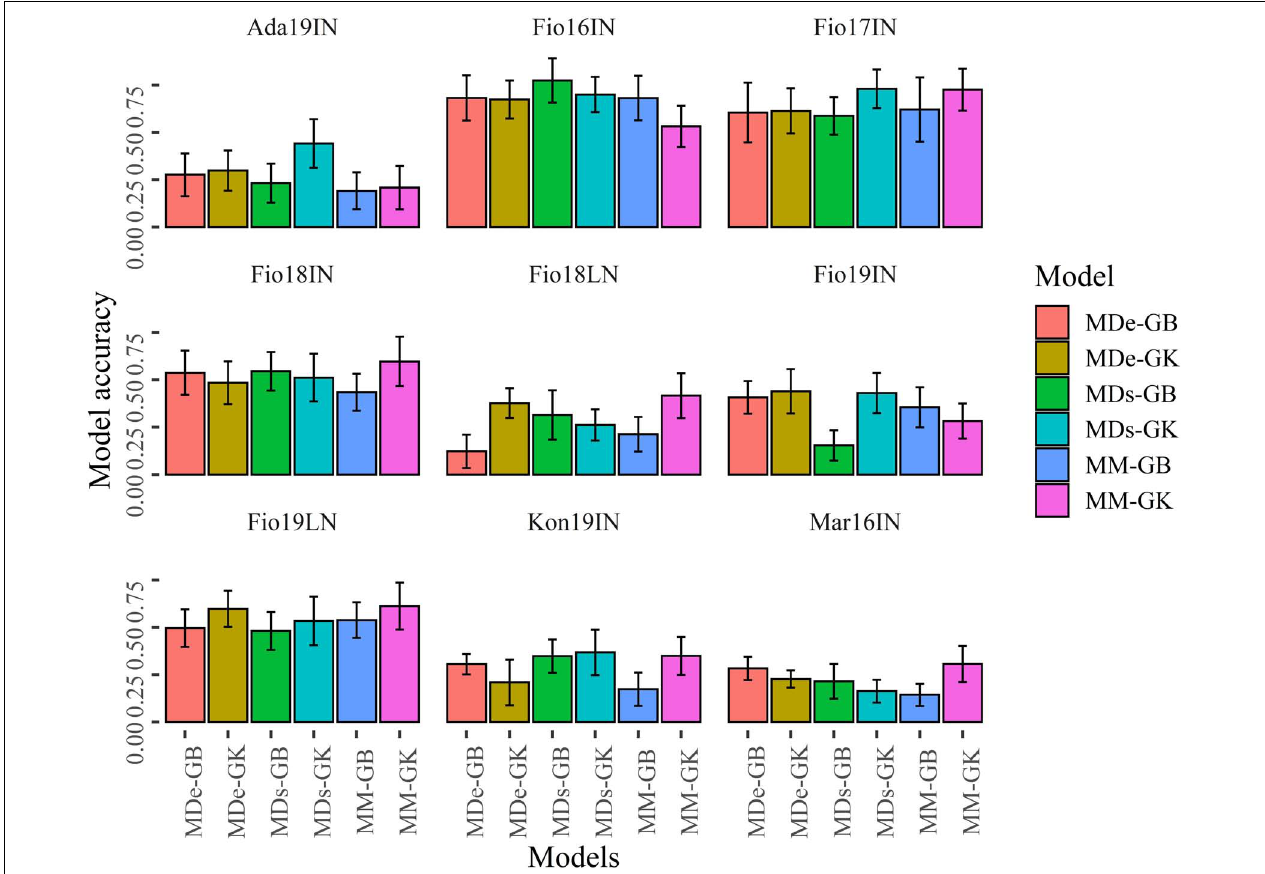
FIGURE 7 | Bar plots of the predictive ability values obtained with CV1. Bar plots show the mean correlation between observed and predicted values of GY obtained with 100 random CV1 partitions for MM, MDs, and MDe models implemented with GBLUP (GB) and Gaussian Kernel (GK) methods. Error bars point out the standard deviation of predictive ability